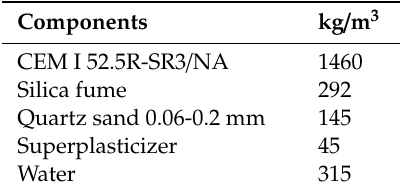
Table 1. Mixture composition of the high-strength, fine-grained cementitious